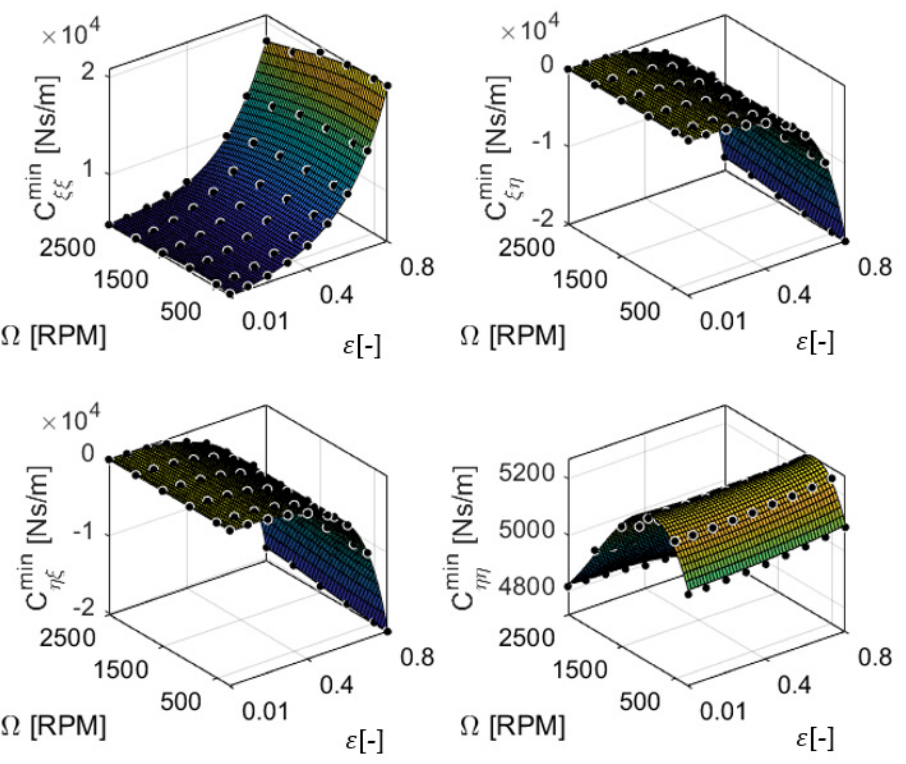
Figure 11. The minimum damping coefficients in the local coordinates, fitted using MATLAB ( poly53 ). The dots represent the results from the fluid film simulations.